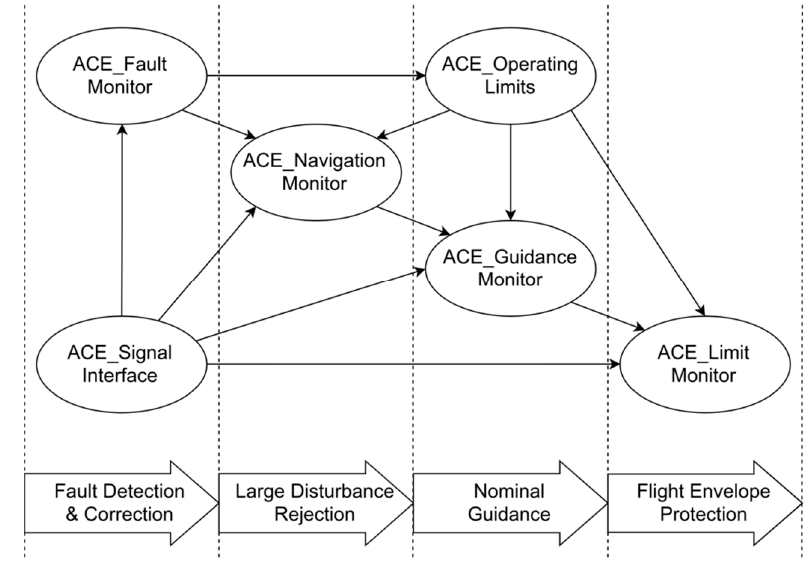
Figure 21. ACE Action Manager components.